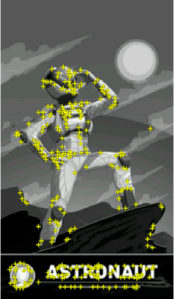
Figure 26. Image target with recognition points highlighted.